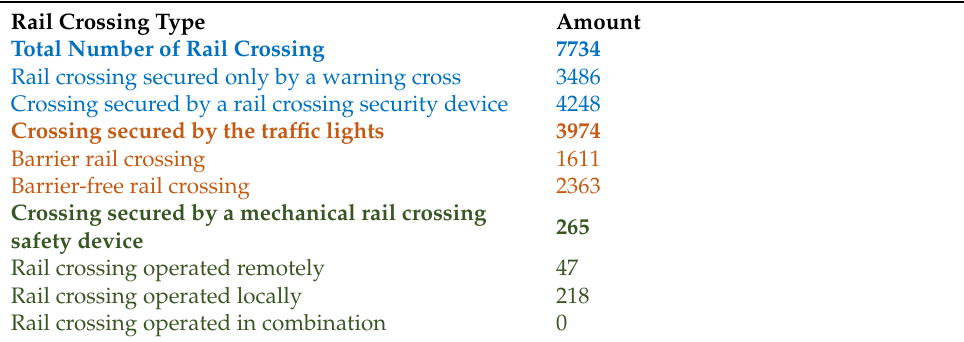
Table 1. Rail crossing numbers according to the types in the Czech Republic